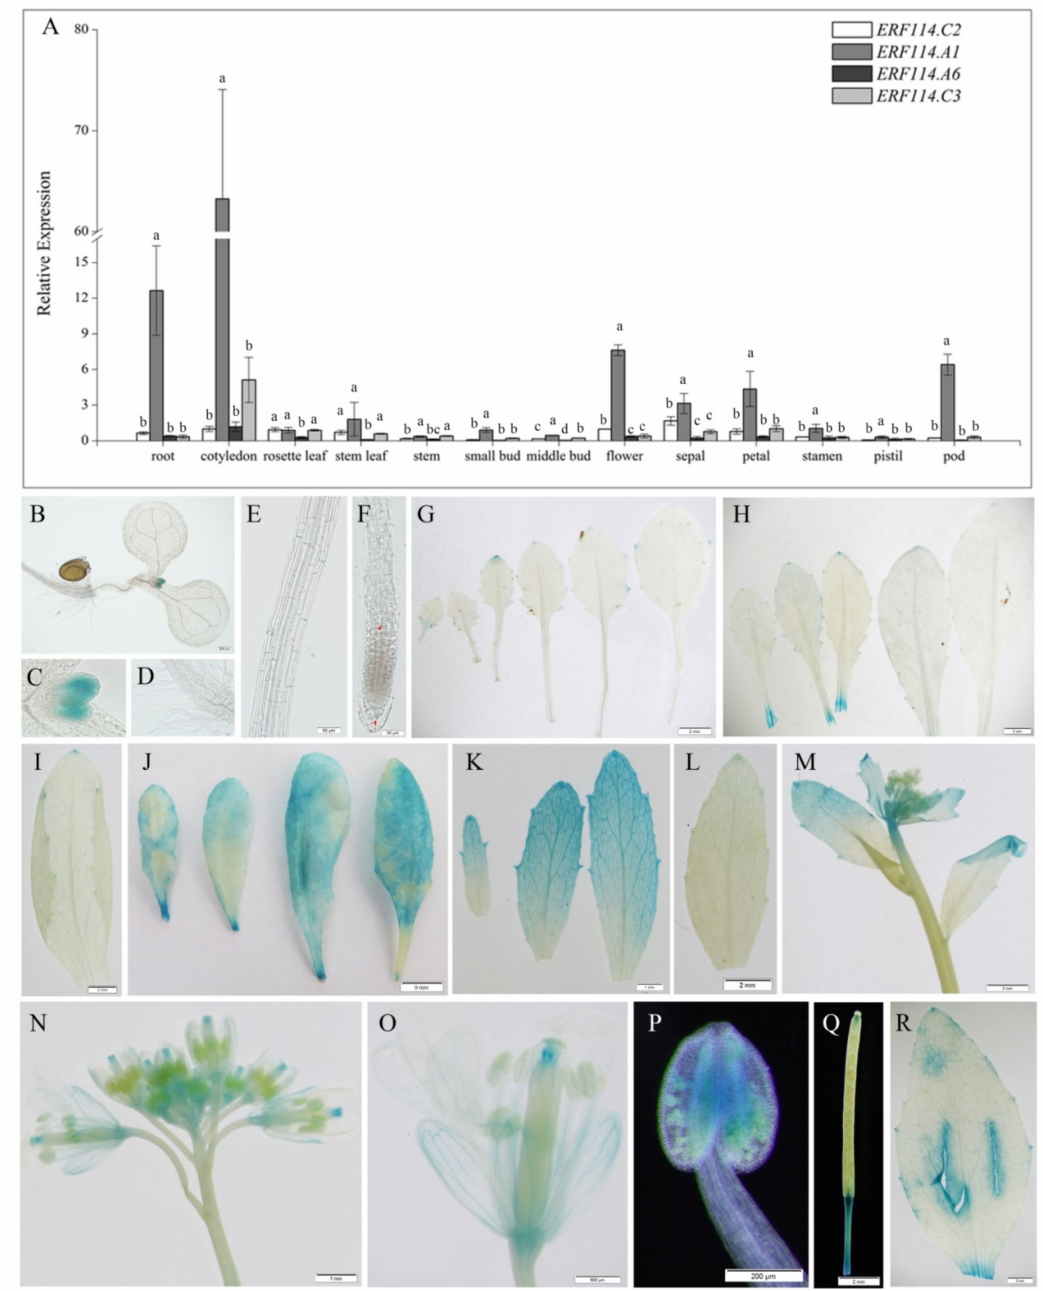
Figure 2. BnERF114s expression profile. ( A ) relative expression levels of BnERF114s in rapeseed different tissues. Gene expression levels were normalised to the reference gene BnUBC21 (Gene ID: 106348550). Relative expression levels of BnERF114s were compared with the expression of BnERF114.C2 in flower. Each column represents the mean of three independent biological replicates, and the error bars indicate standard deviation. Different lowercase letter means significant difference at p = 0.05 level. ( B ) to ( R ), BnERF114.A1 expression patterns identified through histochemical GUS staining in Arabidopsis OE 114 -46-3 transgenic line. ( B ) cotyledon (bar = 100 µ m). ( C ) leaf primordium (bar = 20 µ m). ( D ) root hair (bar = 50 µ m). ( E ) root elongation zone (bar = 50 µ m). ( F ) root tip (bar = 50 µ m). ( G – J ) the youngest to the oldest rosette leaf, respectively ( G – I , bars = 2 mm; J , bar = 9 mm). ( K ) new cauline leaves (bar = 1 mm). ( L ) mature cauline leaf (bar = 2 mm). ( M ) main inflorescence (bar = 2 mm). ( N ) branched inflorescence (bar = 1 mm). ( O ) flower (bar = 500 µ m). ( P ) anther (bar = 200 µ m). ( Q ) pot (bar = 2 mm). ( R ) wounded mature rosette leaf (bar = 2